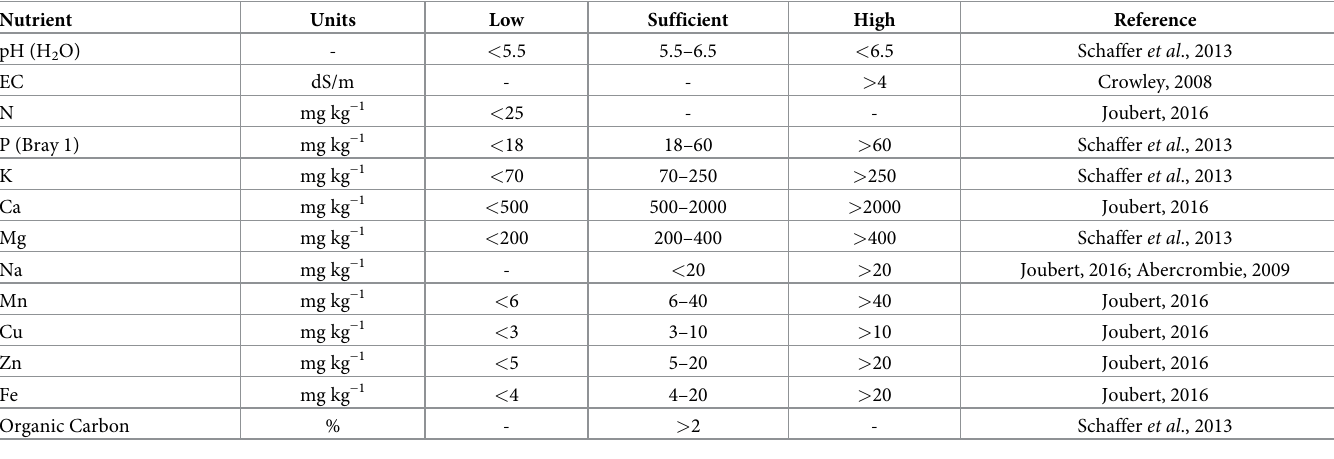
Table 1. Important soil nutrients categories for avocado production as recommended by the ARC-ITSC Nelspruit, South Africa. Nutrient Units